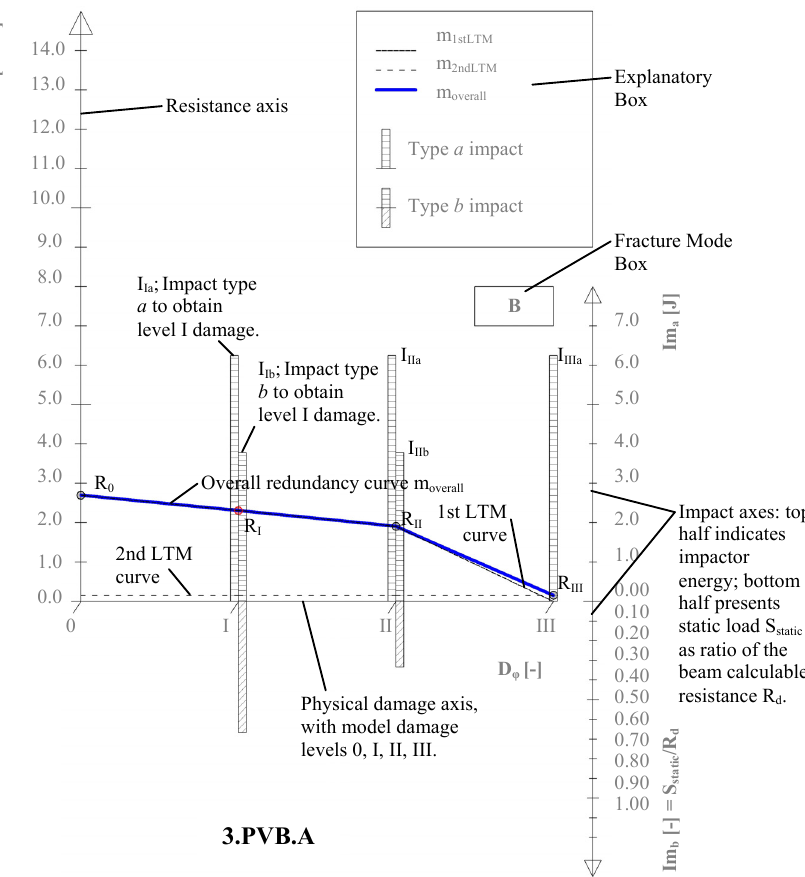
Figure 2: Example ESD of triple layer (‘3’), PVB laminated (‘PVB’), annealed (‘A’) glass beam. LTM = Load Transfer Mechanism. 2. Results: Element Safety Diagrams of 14 Glass Beam